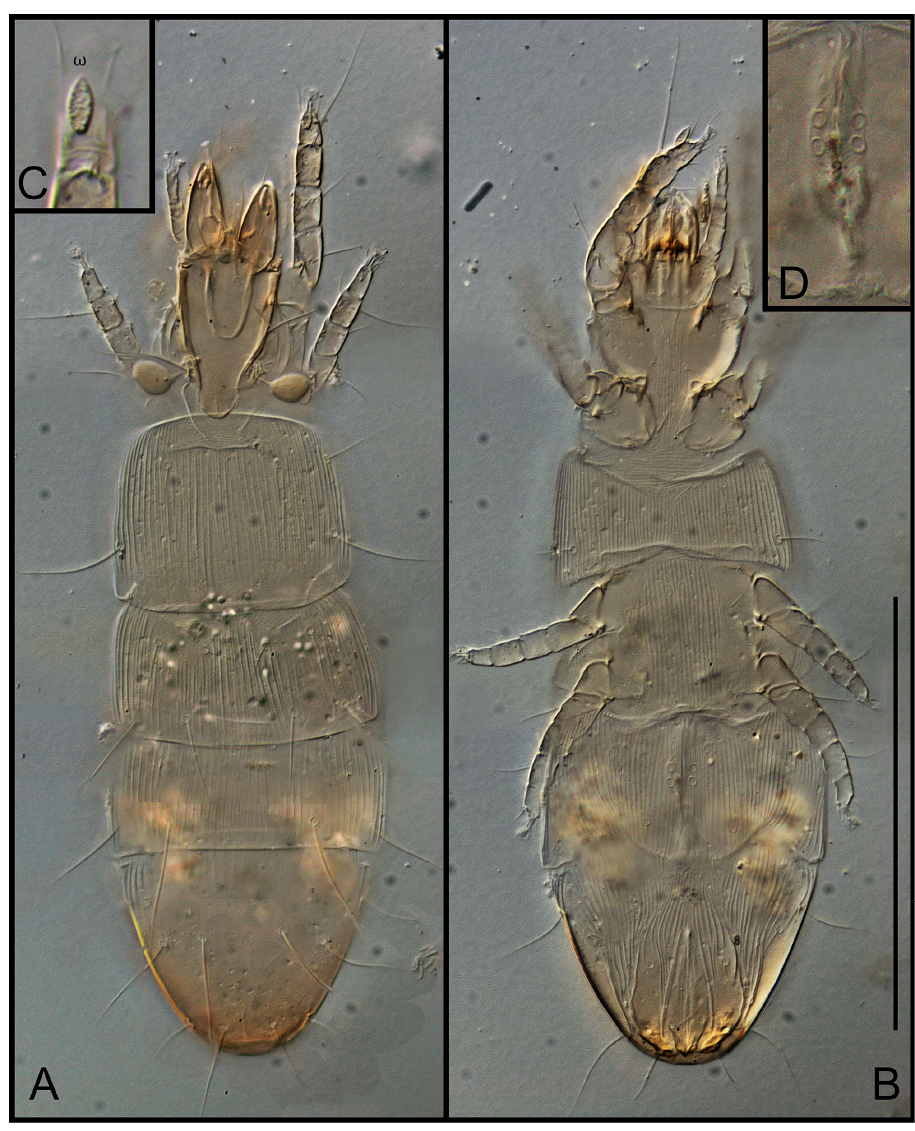
Figure 13. Paralycus persephone sp. n., female, light microscope images: ( A )—dorsal view; ( B )—ven- tral view; ( C )—solenidion ω I; ( D )—genitals. Scale bar 100 µm.